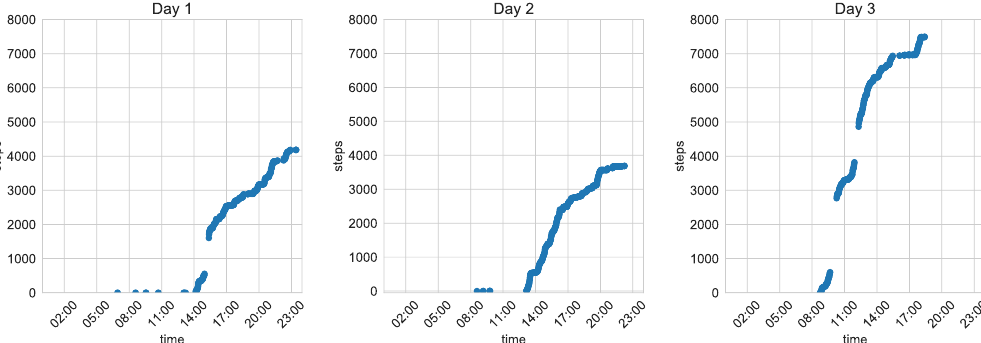
Figure 17. Number of steps taken by the older person during three selected days (Day 1–3) of the